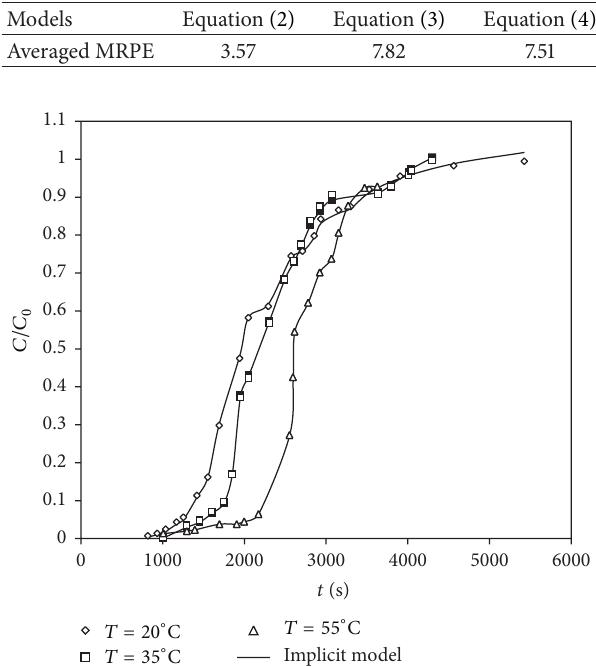
Table 3: Calculation results of the coefficients of (2) at temperatures 20, 35, and 55 ∘ C.